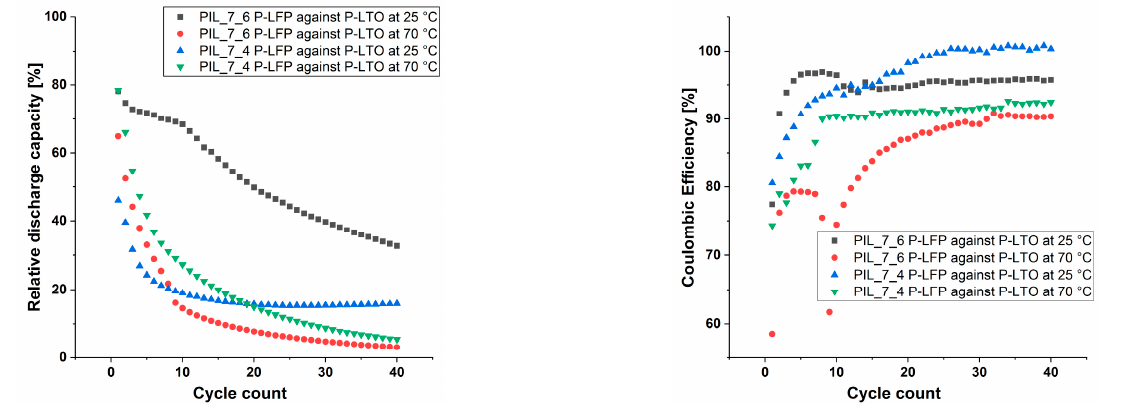
Figure 10. Discharge capacities relatively to the theoretical capacity of the electrode materials ( left ) and coulombic efficiencies ( right ) over the cycle count.